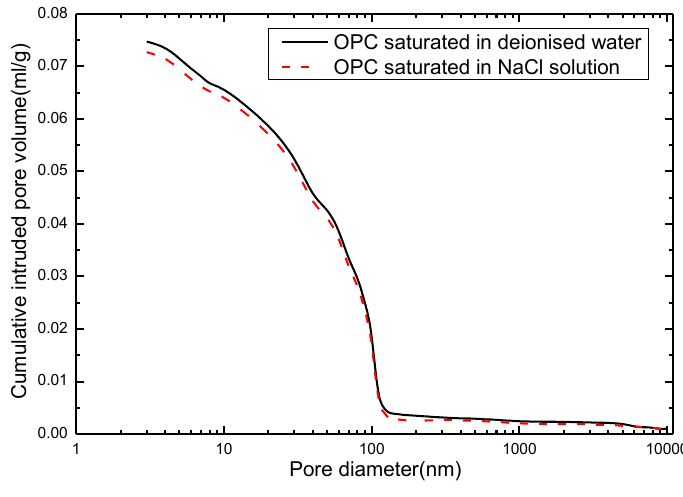
Figure 6. The cumulative intruded pore volume of ordinary Portland concrete immersed with different solutions (deionised water and NaCl